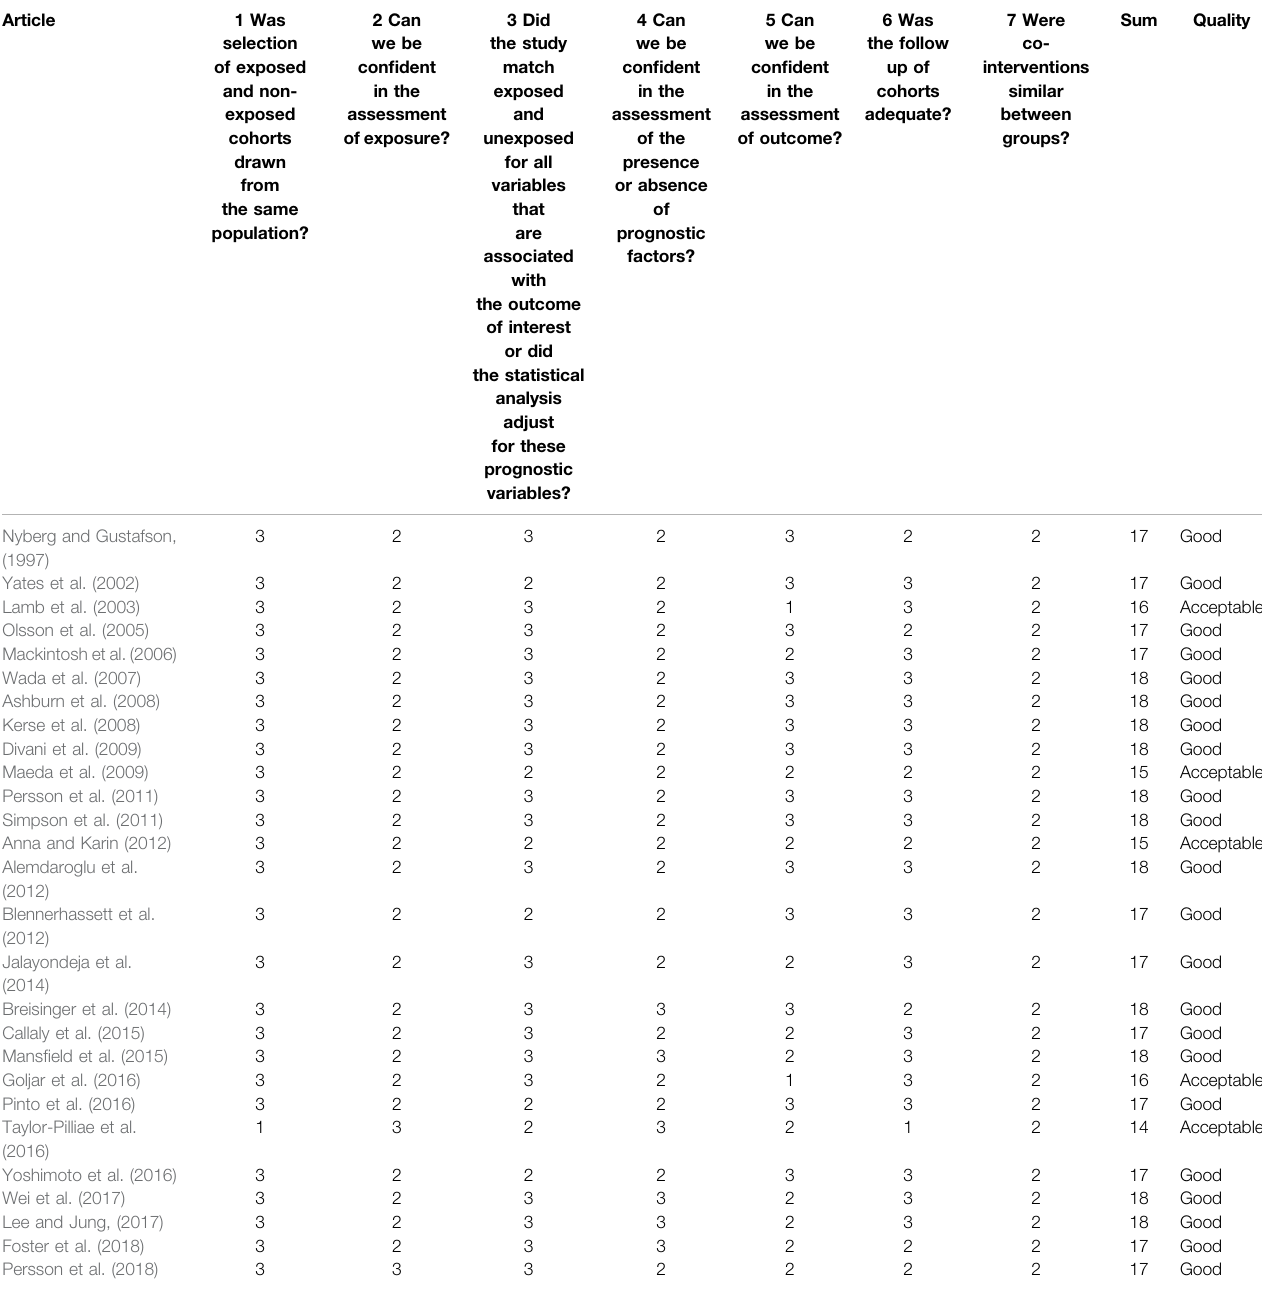
TABLE 2 | Risk of bias assessment using Cochrane Tool to Assess Risk of Bias in Cohort